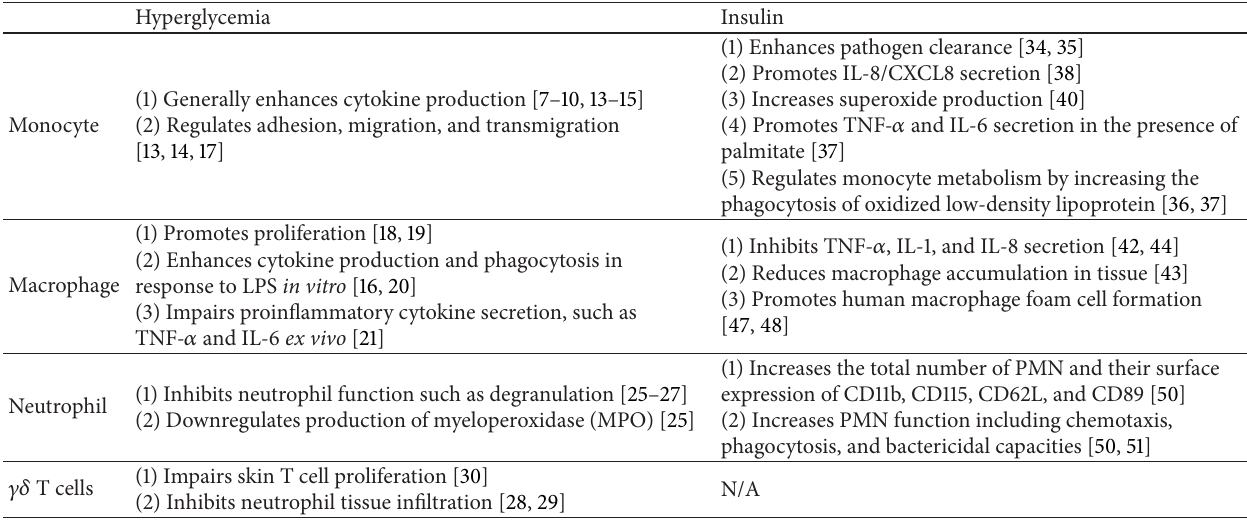
Table 1: Effects of hyperglycemia and insulin on innate immune